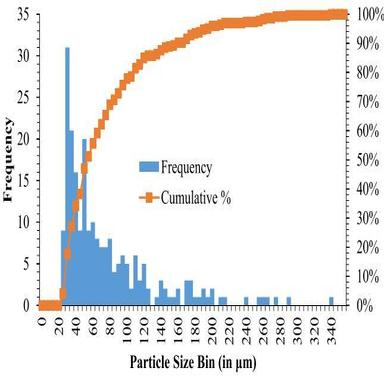
Cluster size analysis of sorbitol.